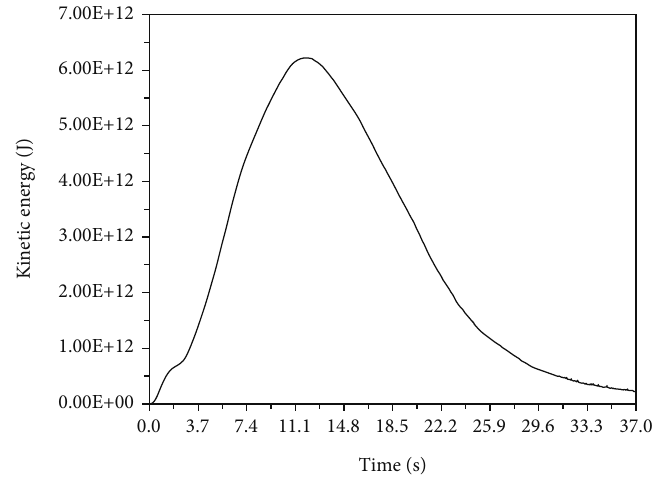
Figure 15: Slip kinetic energy time